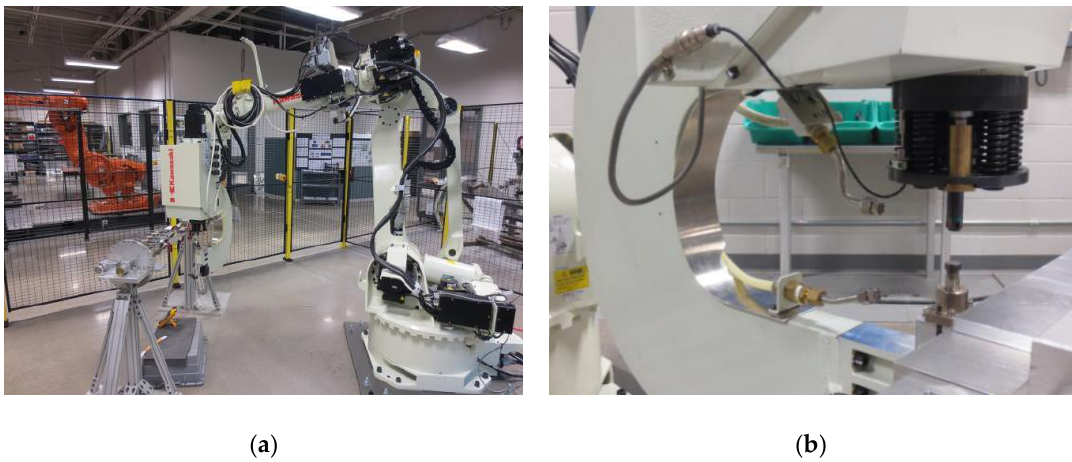
Figure 1. Refill friction stir spot welding work-cell: ( a ) refill friction stir spot welding robot; ( b ) refill friction stir spot welding end effector.